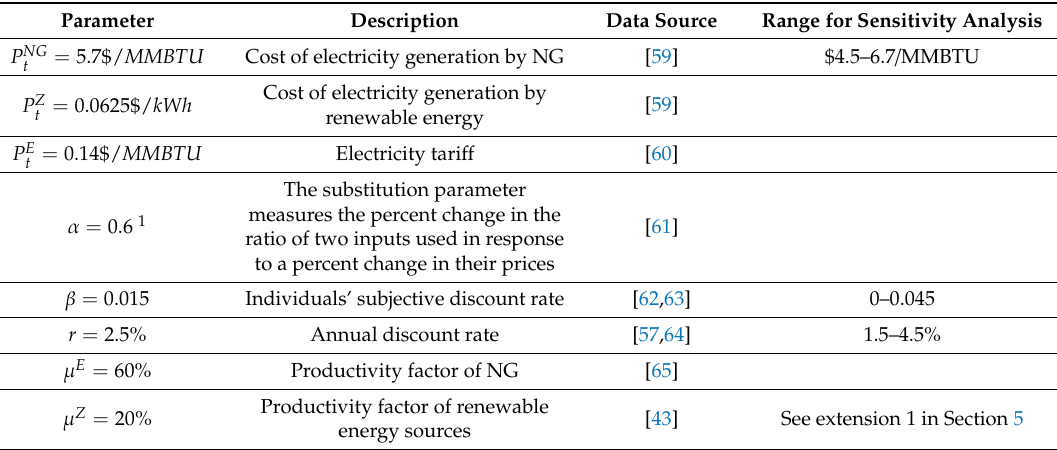
Table 3. Parameter values and sources in the three scenarios.